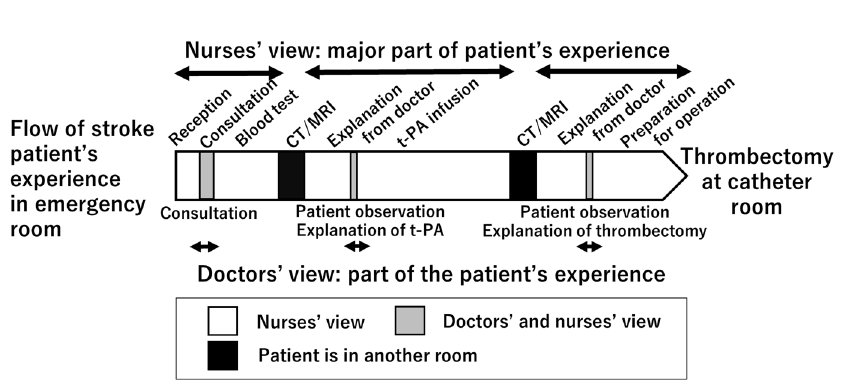
Figure 1. Differences in views between doctors and